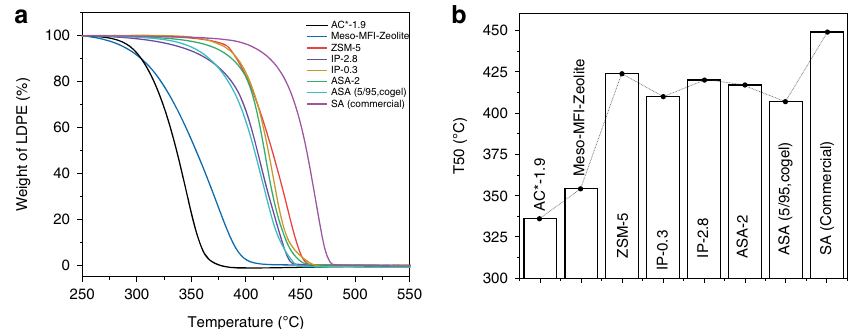
Fig. 9 Comparison of solid acids for LDPE pyrolysis. a Weight loss curve, b T50 ’ s, using various solid acids (2 mg) and LDPE (6 mg). Error in the T50 is ±3 °C.